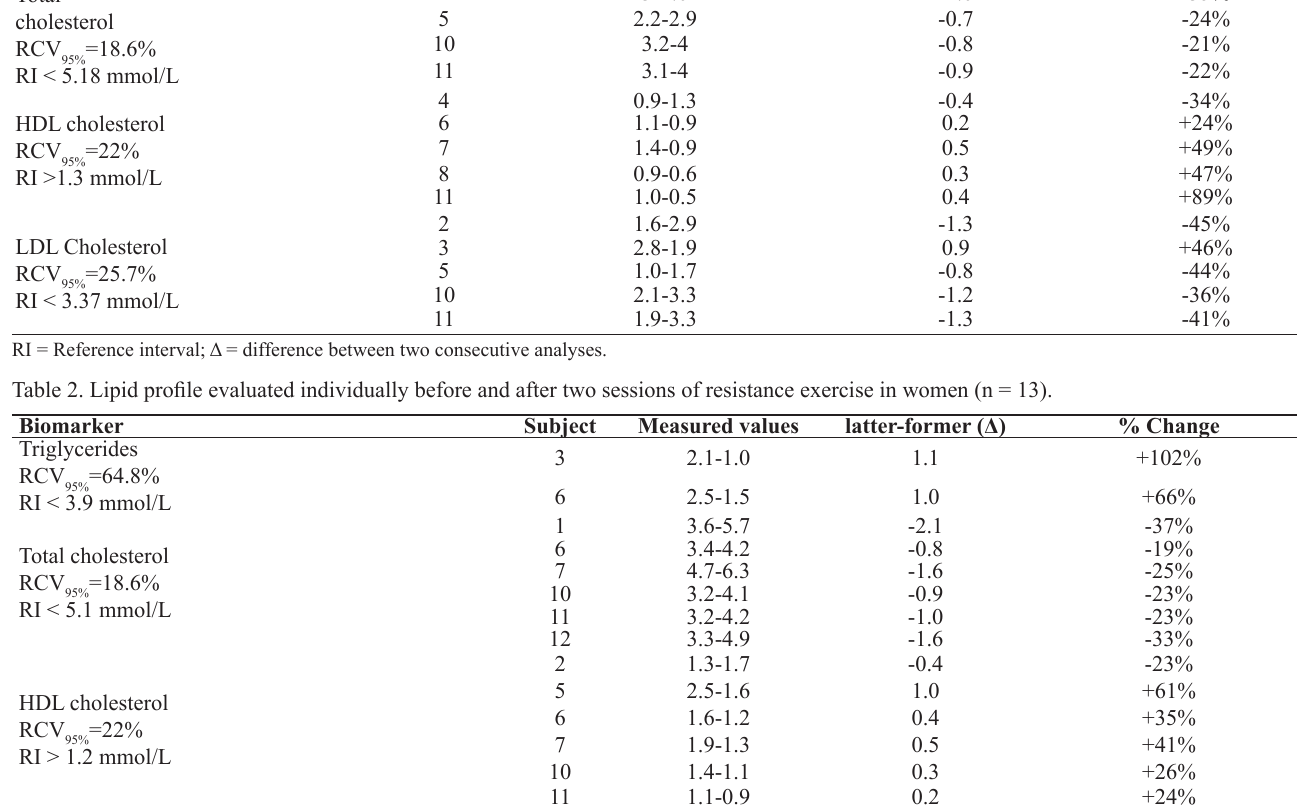
Table 1. Lipid profile evaluated individually before and after two sessions of resistance exercise in men (n = 11). Biomarker Total